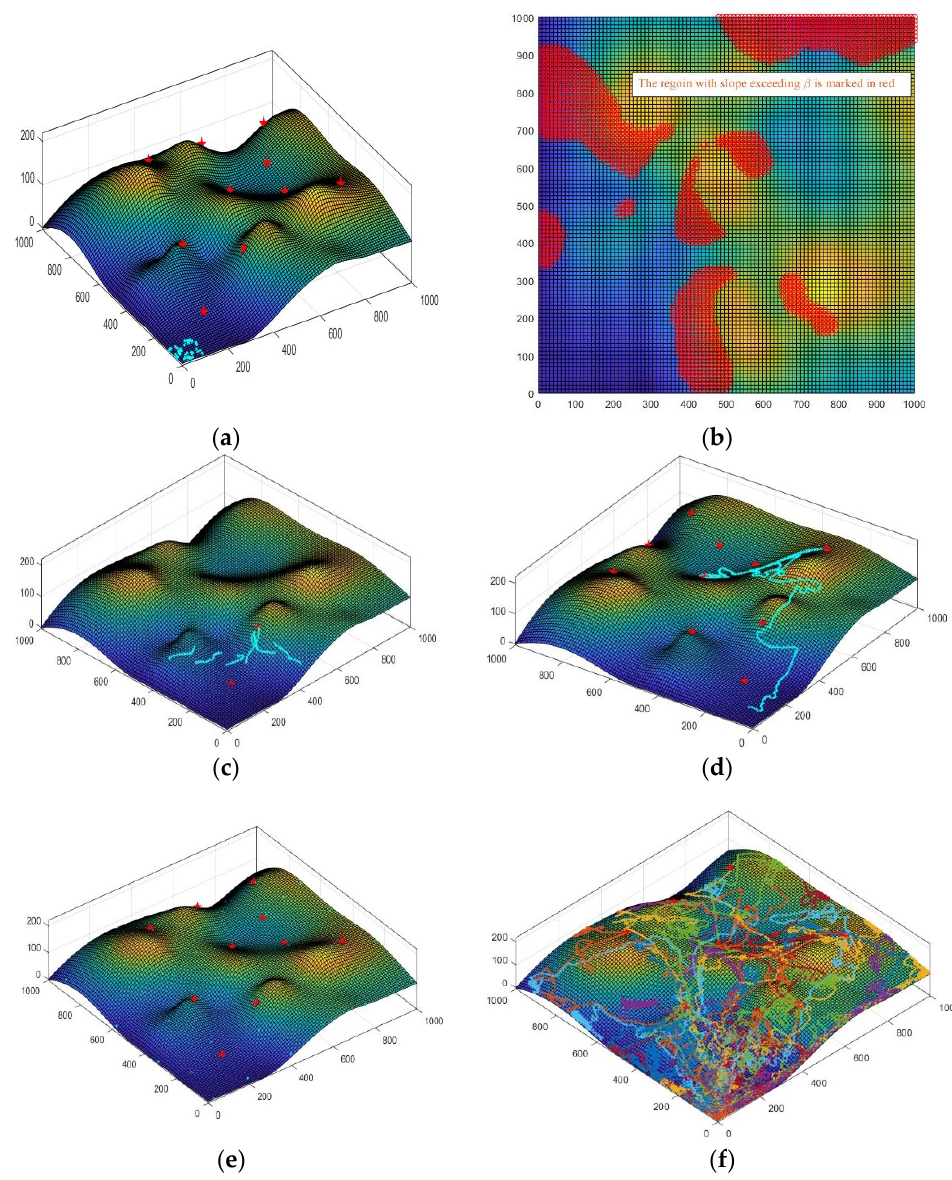
Figure 6. 3D simulation of a target search when the slope is greater than β . ( a ) Mountainous terrain, initial target positions. ( b ) Diagram of the slope over the β zone. ( c ) The robots search for tar 6 . ( d ) Trajectory of robot R 21 ( e ) When t = 329, the swarm robots have found all targets. ( f ) The trajectories of all the robots.